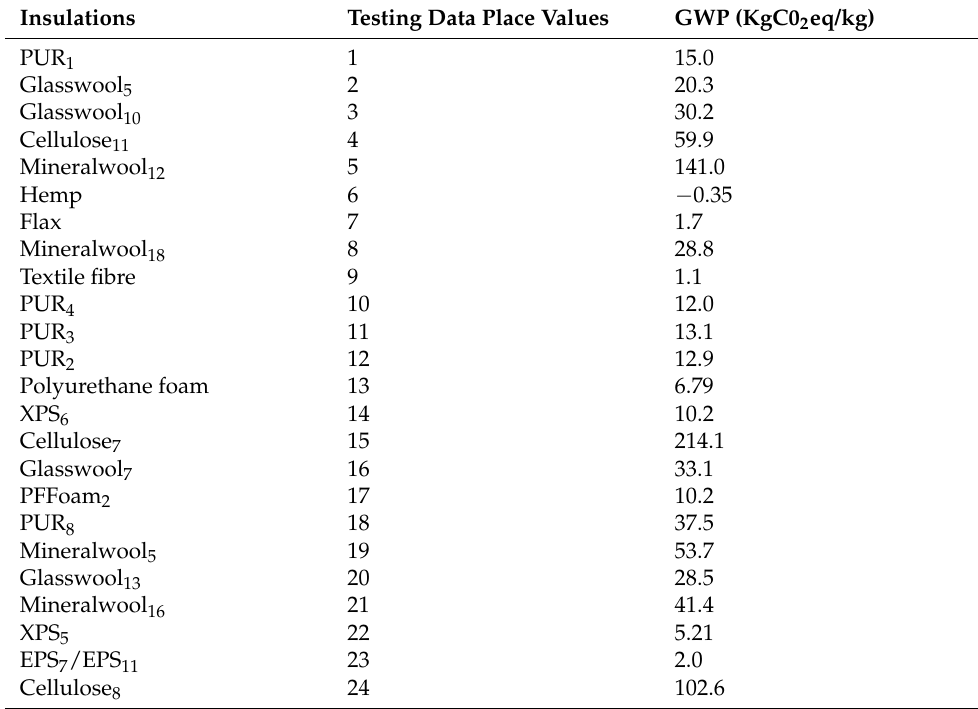
Table 2. Randomised Testing Data for the Holdout